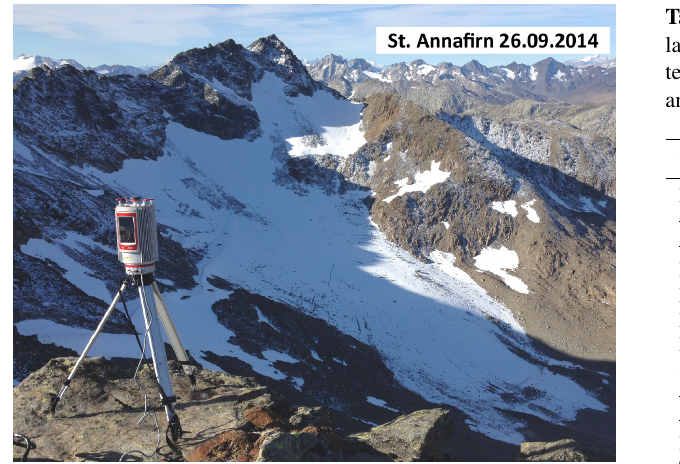
Figure 2. TLS survey of St. Annafirn in September 2014 with the Riegl VZ ® -6000 terrestrial laser scanner.